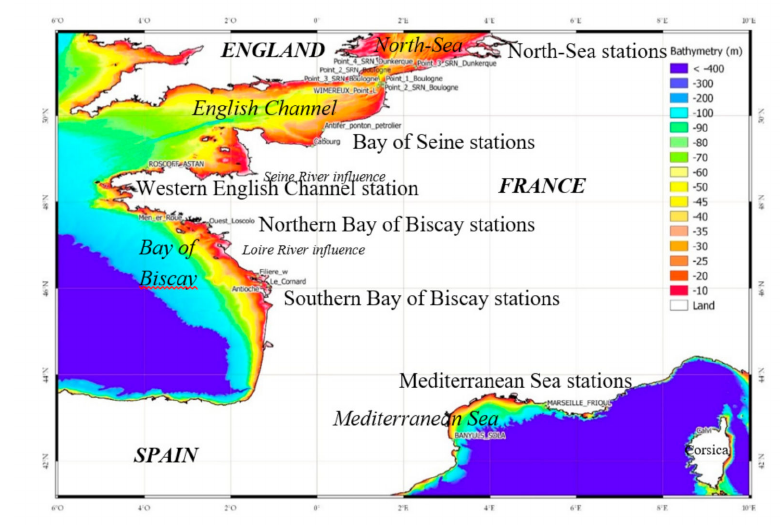
Figure 1. Maps of the selected 17 stations and bathymetric